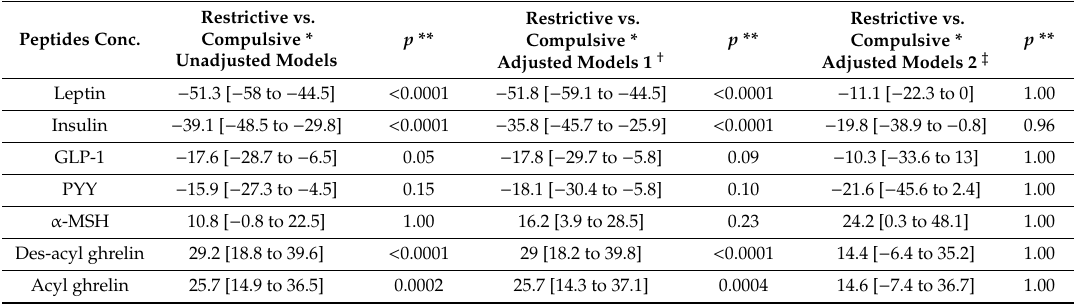
Table 2. Linear models explaining peptide concentrations associated with food intake according to di ff erent adjustments. Peptides